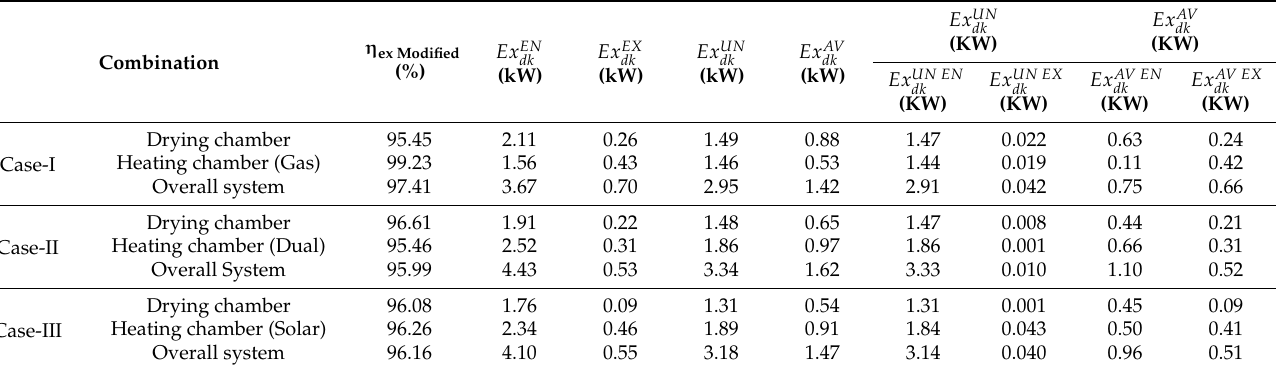
Table 6. Advanced exergy analysis for the solar hybrid